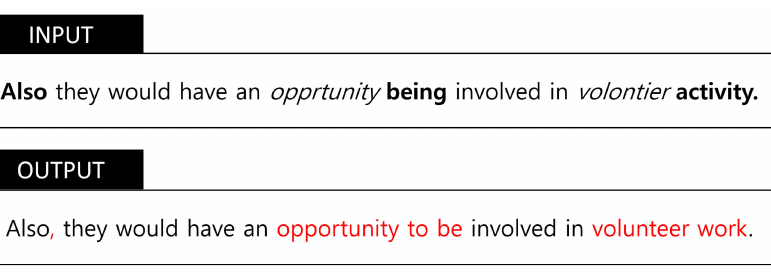
Figure 1. Grammatical Error Correction (GEC)